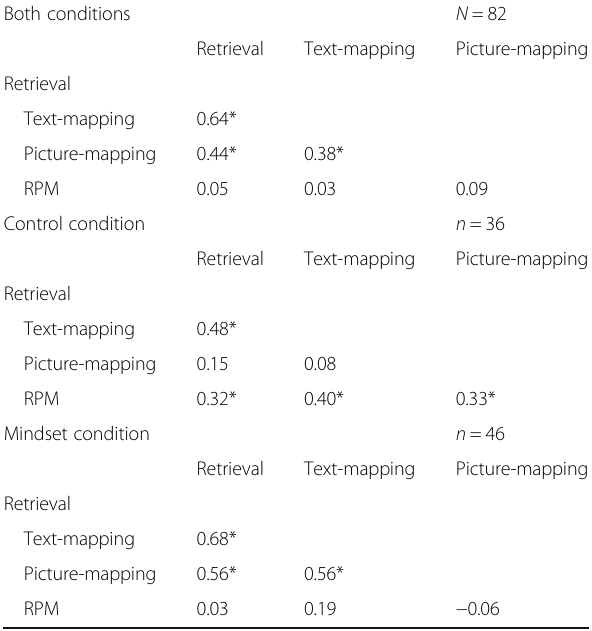
Table 2 Correlations ( r scores) between relational retrieval, ratings of the relational match passage in the text-mapping task, relational choices in the picture-mapping task, and Raven ’ s Progressive Matrices (RPM) scores for experiment 2 Both conditions N =